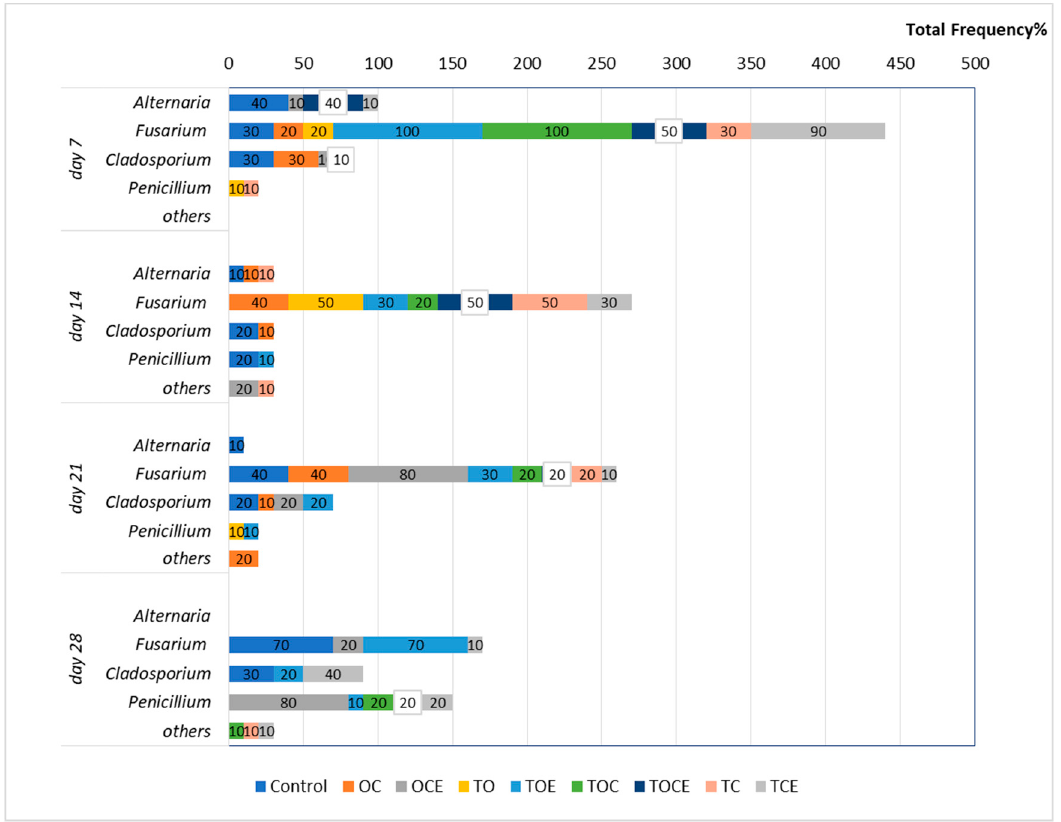
Figure 1. The total fungi frequency (Fr%) after 7, 14, and, 28 days of treatment with EOs and natural preparations. OC—binary mixture of oregano and coriander EOs; OCE—binary emulsion of oregano and coriander EOs; TO—binary mixture of thyme and oregano EOs; TOE—binary emulsion of thyme and oregano EOs; TC—binary mixture of thyme and coriander EOs; TCE—binary emulsion of thyme and coriander EOs; TOC—tertiary mixture of oregano, coriander, and thyme EOs; TOCE—tertiary emulsion of oregano, coriander, and thyme